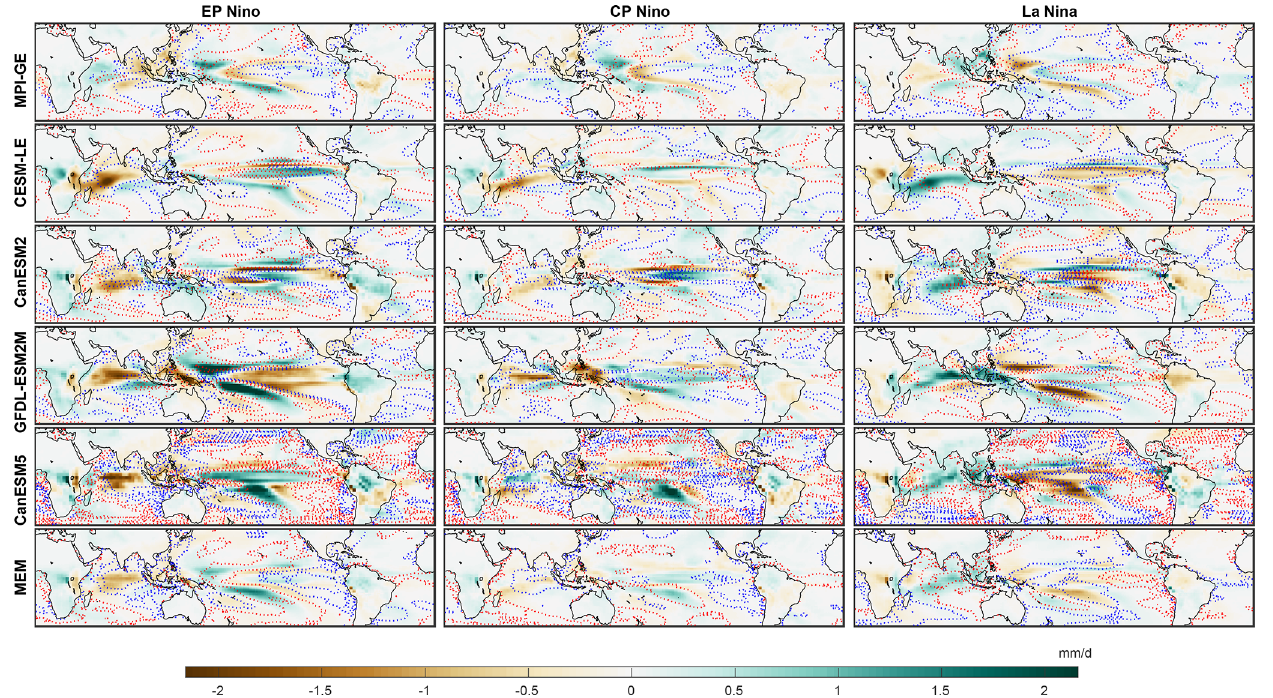
Figure 6. Change in precipitation pattern in each SMILE in the period 2050–2099 as compared to 1950–1999 for EP and CP El Niño events and for La Niña events (left, middle, and right columns respectively). The SST change from Fig. 5 is shown as contours for reference (blue for cooling, red for warming); shown for each individual SMILE (in order of appearance: MPI-GE, CESM-LE, CanESM2, GFDL- ESM2M, CanESM5) and the multi-ensemble mean (bottom row). The precipitation pattern is calculated as the November, December, January average and composited for each event type over each time period. SMILE data have the forced response (ensemble mean) removed prior to